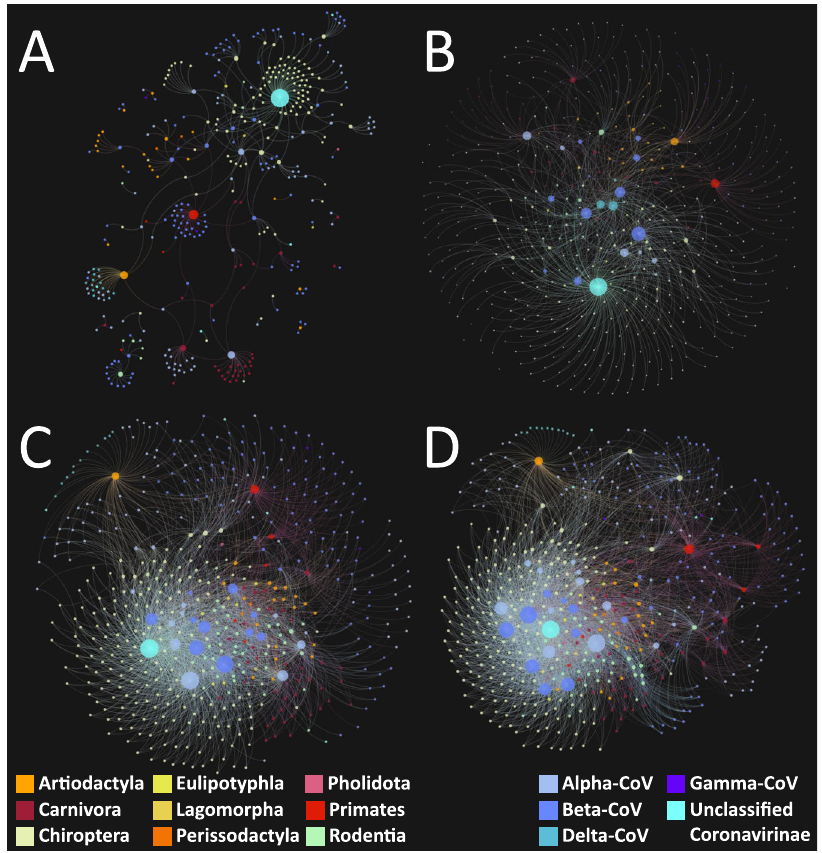
Fig. 3 Bipartite networks linking coronaviruses with mammalian hosts. Panel ( A ): original bipartite network based on known/observed virus – host associations extracted from meta-data accompanying genomic sequences and supplemented with publications data from the ENHanCEd Infectious Diseases Database (EID2). Panels ( B – D ) show predicted bipartite networks using our predicted virus – host associations at different cut-offs: ≥ 0.9821, >0.75 and >0.5, respectively, for mean probability of